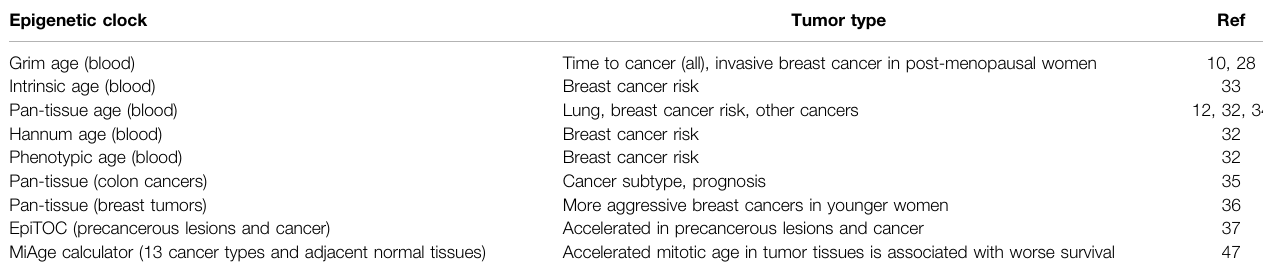
TABLE 2 | Epigenetic clocks predictive of cancer risk. Epigenetic